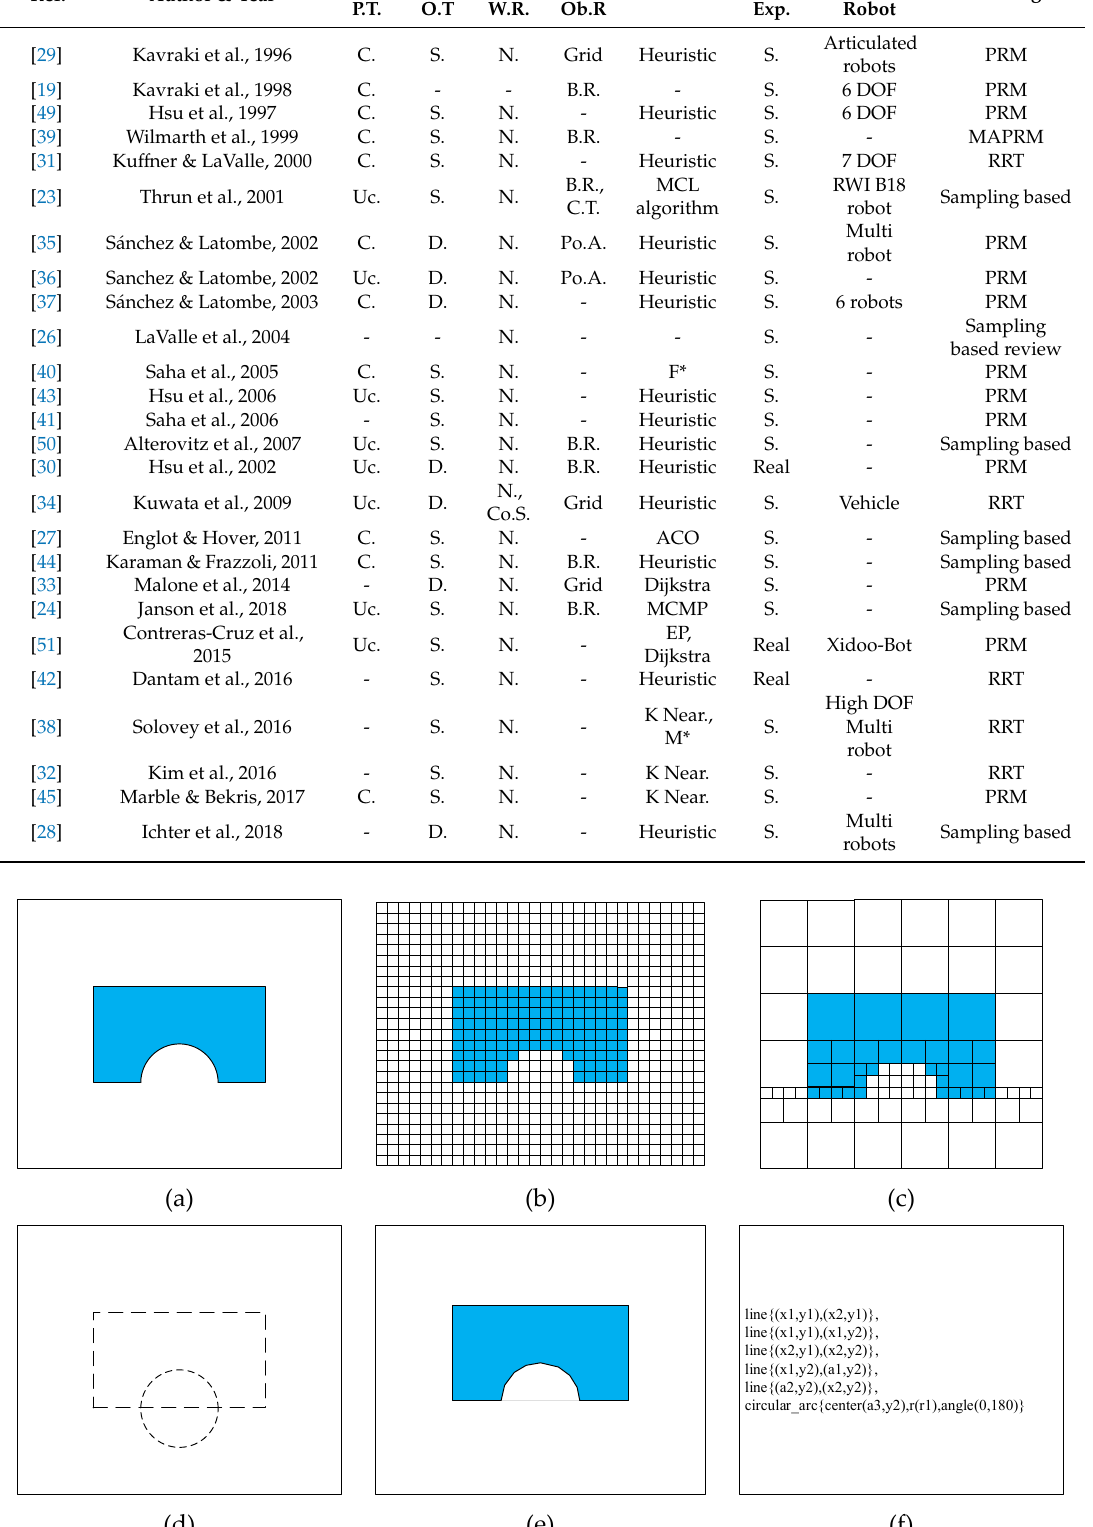
Table 2. Classification of the papers while using the sampling-based algorithm. Ref.